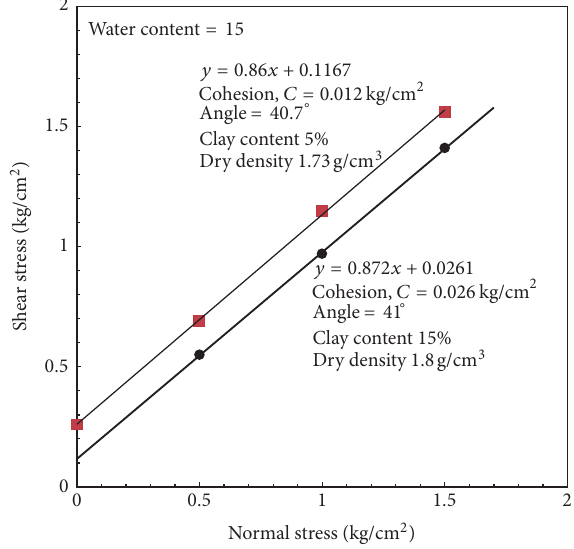
F 9: Shear strength envelope for clay-sand mixture.